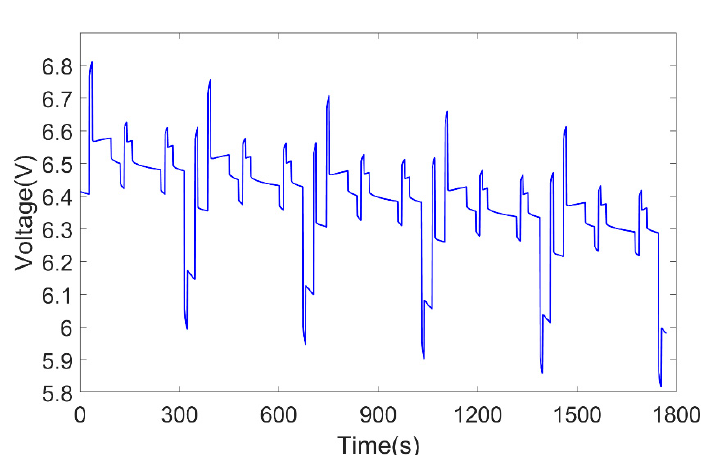
Figure 22. Current profiles under DST test.